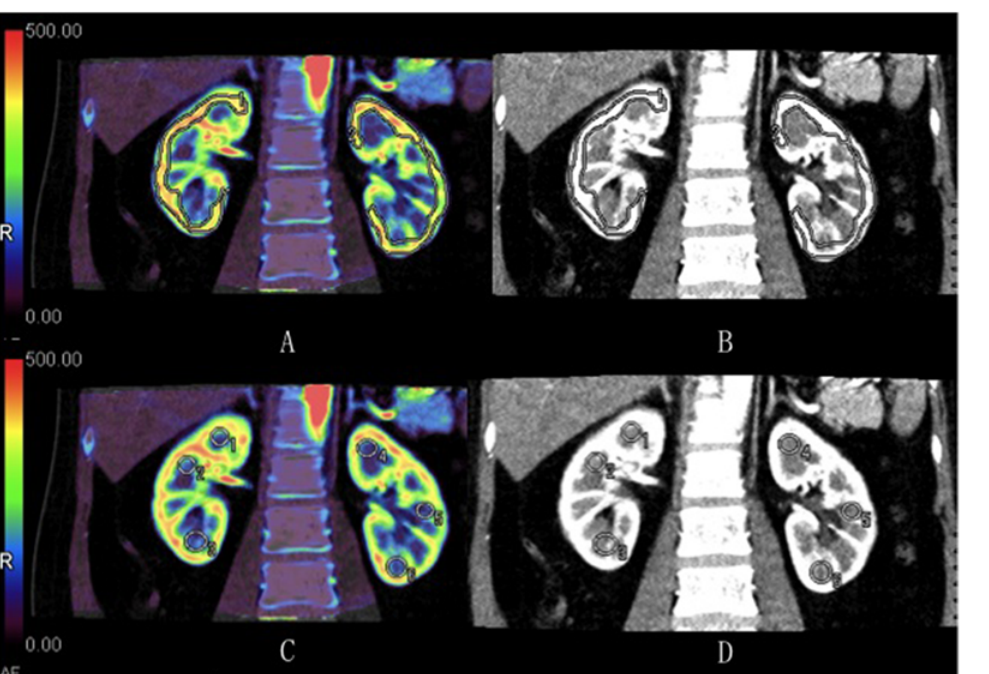
Fig 2. Examples for regions of interest (ROIs) measurements. ROIs of renal cortex (a, b) and medulla (c, d) were defined manually in the coronal plane.